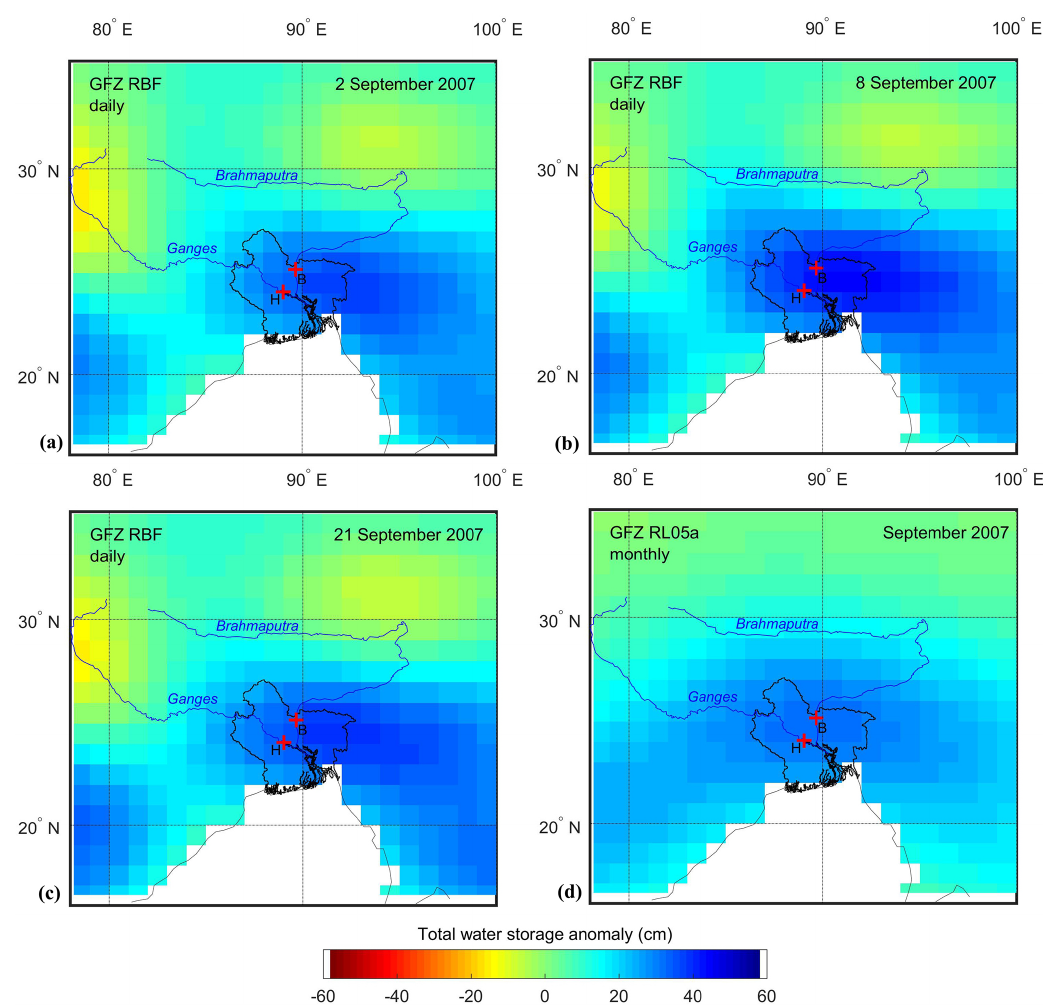
Figure 8. Daily and monthly water storage anomalies of the GFZ RBF solution for the Ganges–Brahmaputra Delta on (a) 2 September 2007, (b) 8 September 2007, (c) 21 September 2007 and (d) September 2007. Key is as in Fig.